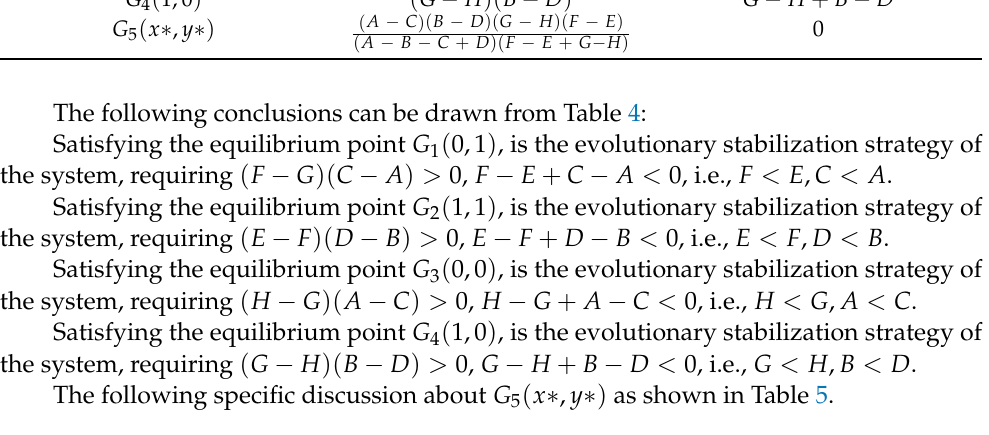
Table 5. Asymptotic stability of the equilibrium point of the two-sided game system of Q and